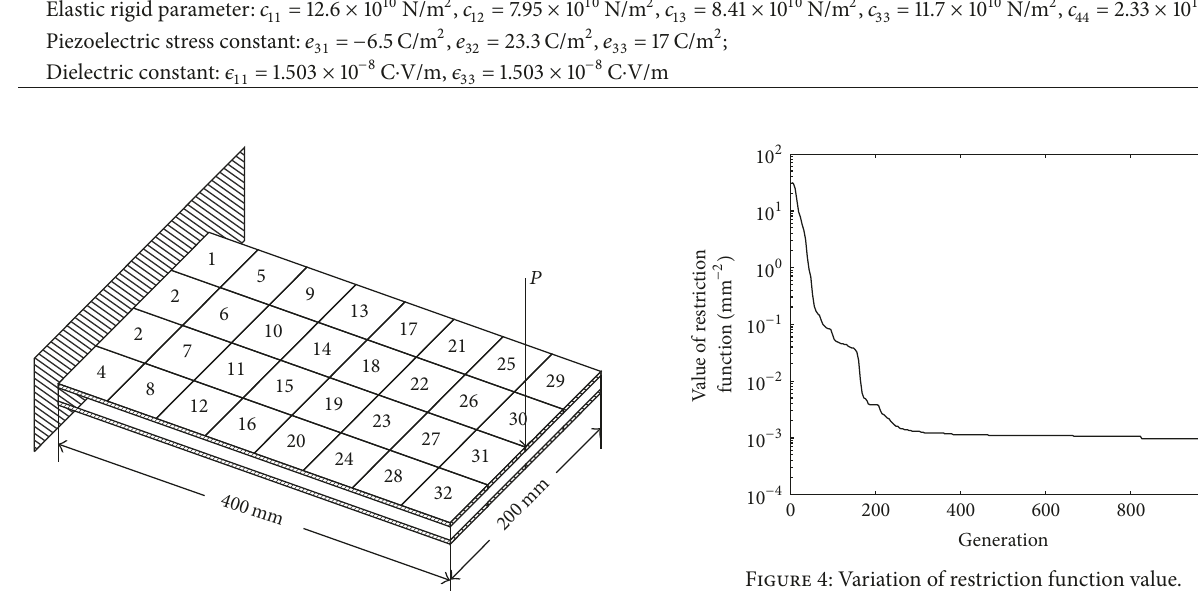
Figure 4: Variation of restriction function